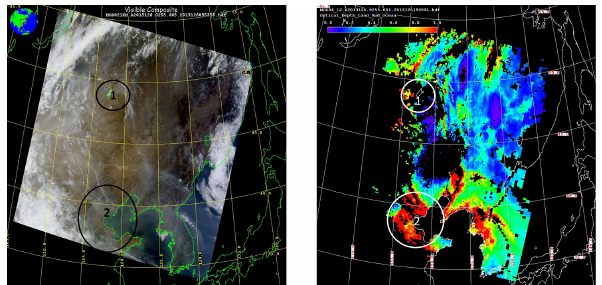
Figure 6. The RGB image (left) and Aerosol Optical Depth (right) from MODIS on 6 May 2013. Circle 1 and circle 2 represent the Hulunbuir sand land and the Bohai Bay respectively. (The figures are from https://ladsweb.nascom.nasa.gov/browse_images/